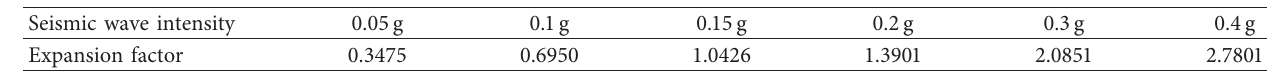
Table 6: Expansion factors of seismic